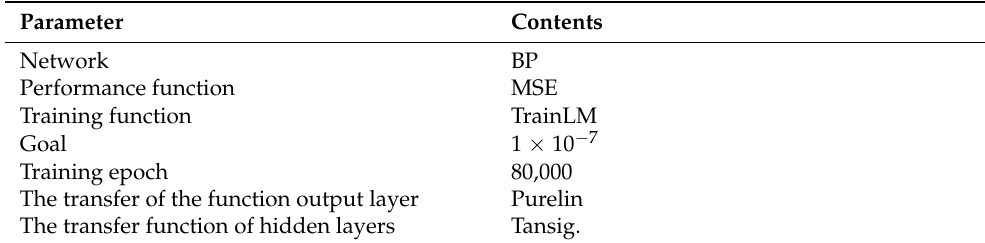
Table 5. Training parameters used in the current